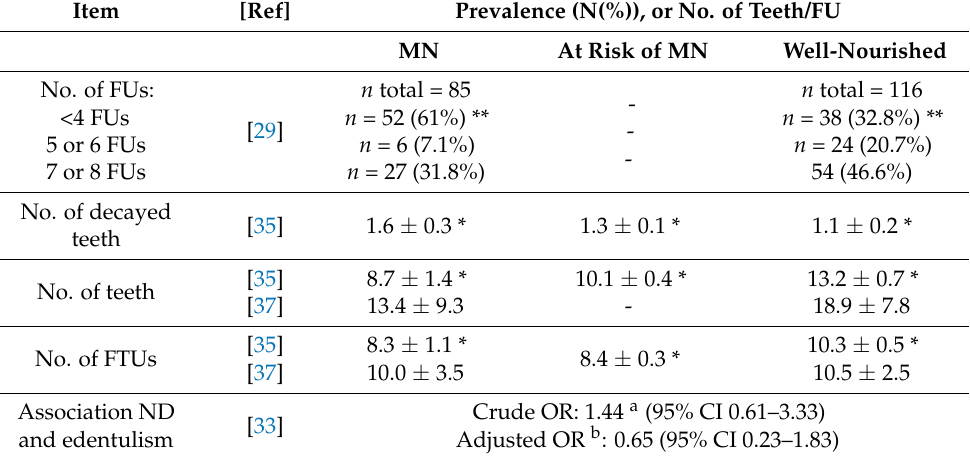
Table 2. Outcome measures regarding hard tissue conditions in malnourished older people compared to well-nourished older